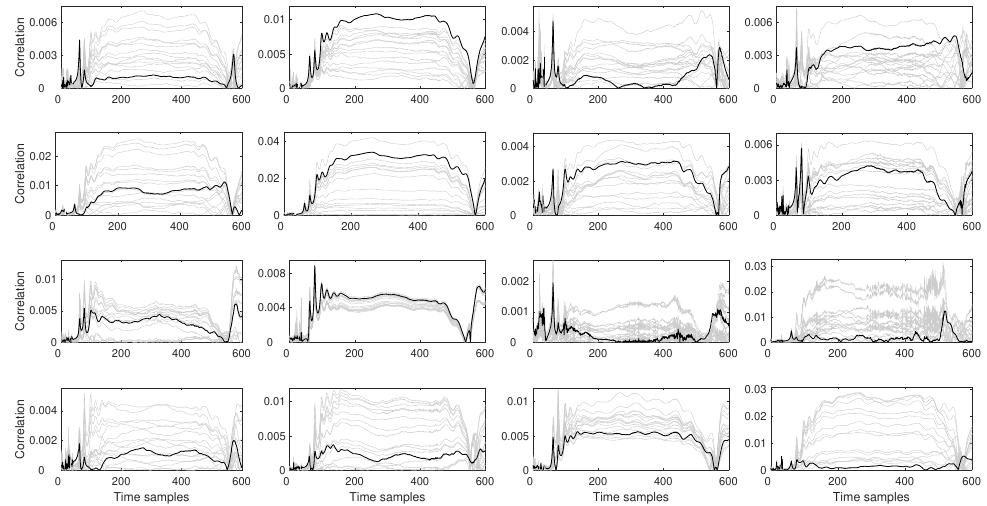
Figure 14: MCDPA attack on unrolled PRINCE using 100 million traces when the plaintext is reset to a random state between encryptions. Results for 16 key differences (0-1, 1-2, ..., 14-15, 15-0) are